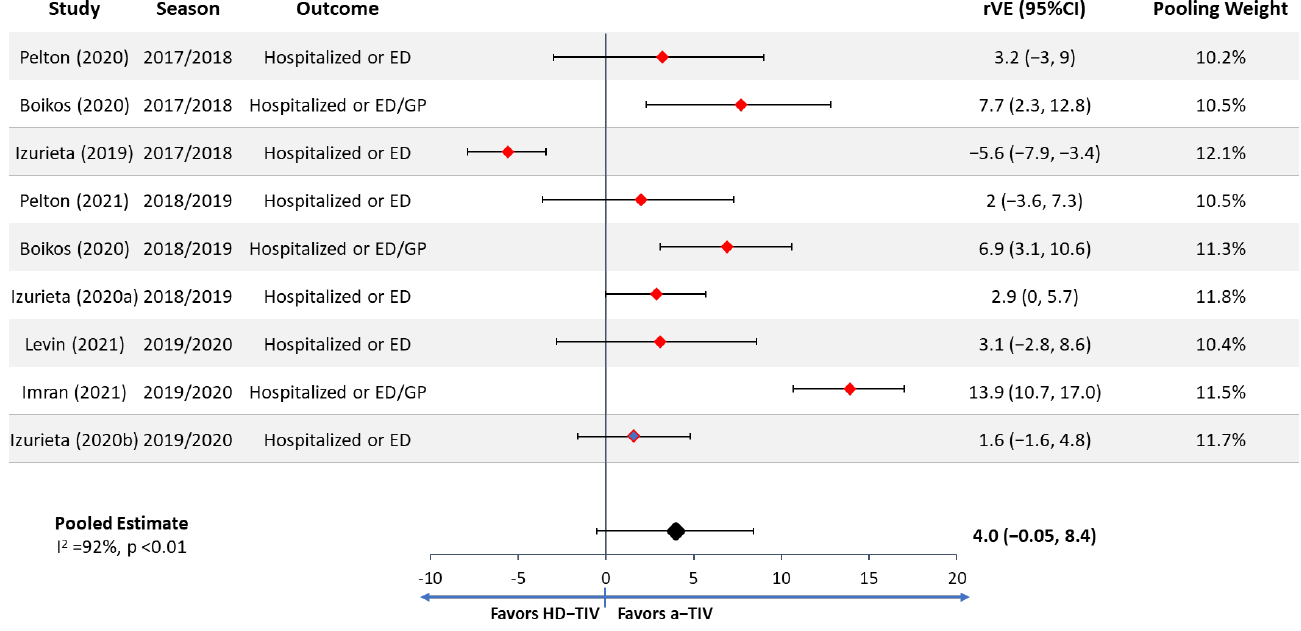
Figure 2. Meta-analysis of effect estimates from identified studies reporting the relative vaccine effectiveness of aTIV vs. HD-TIV for prevention of influenza-related hospitalizations (or composite outcomes including influenza-related hospital admissions). Study pooling weights were calculated based on DerSimonian and Laird random-effects meta-analysis [41]. Abbreviations: CI = confidence interval; ED = emergency department; GP = general practitioner; rVE = relative vaccine